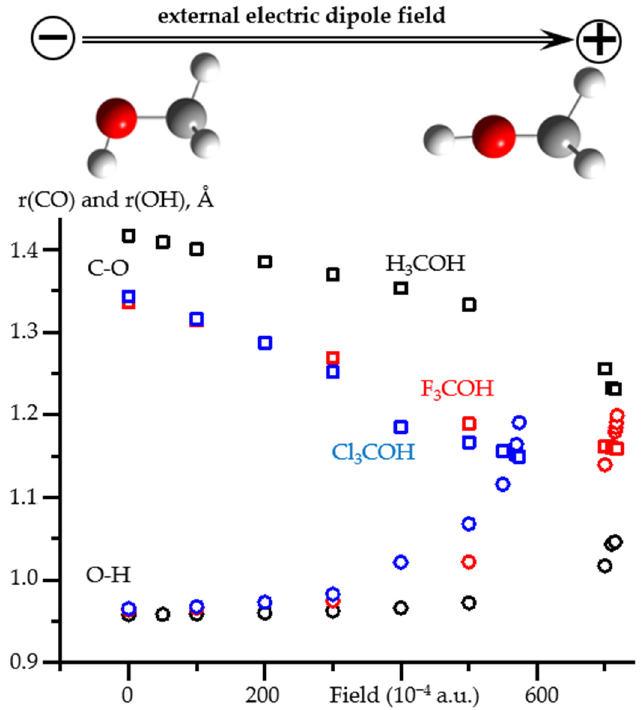
Figure 8. The O-H and C-O distances as functions of an external electric field applied to H 3 COH, F 3 COH, and Cl 3 COH at PCM = water. The O-H distances: H 3 COH (black squares), F 3 COH (red squares), and Cl 3 COH (blue squares). The C-O distances: H 3 COH (black circles), F 3 COH (red circles), and Cl 3 COH (blue circles). The orientation of the acids relative to the direction of the field is shown for H 3 COH.